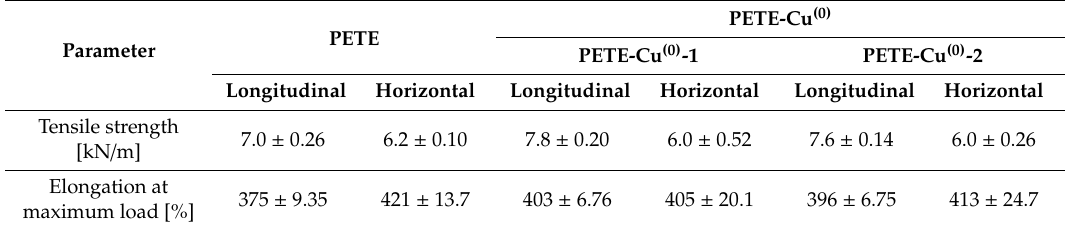
Table 5. The results of tensile strength test of the unmodified PETE fabrics and PETE-Cu (0) composites, in accordance with the EN ISO 10319:2015